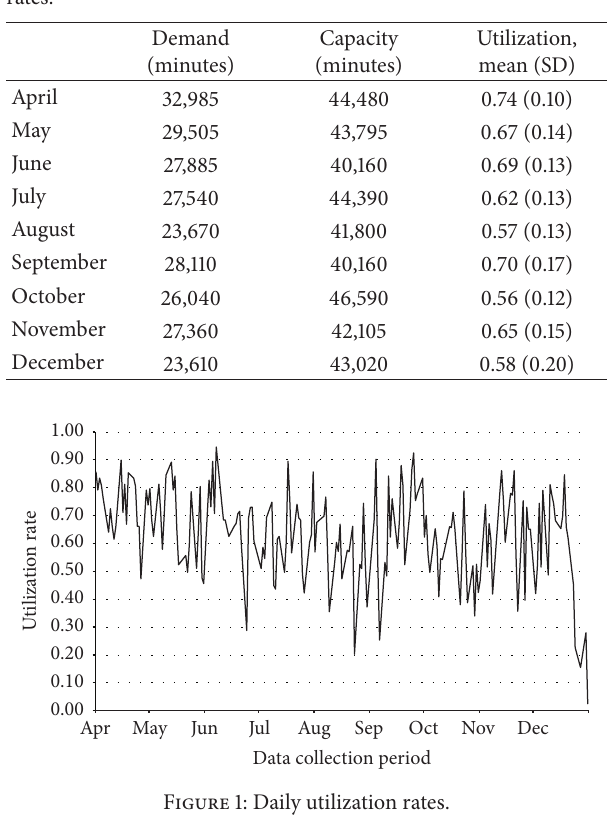
Table 2: Monthly mean demand, capacity, and resource utilization rates.